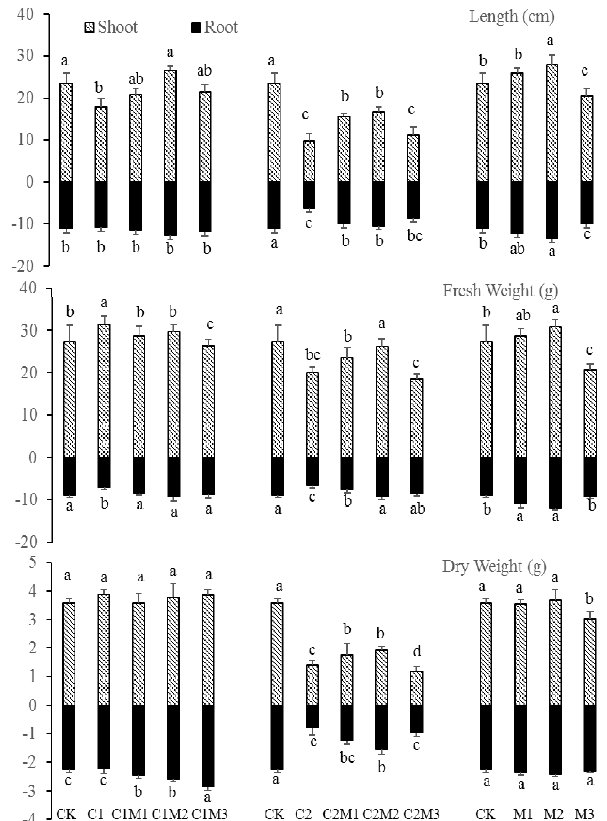
Figure 1. The biomass of rape plants with the co-treatment of Mo and Cd ( n = 4). Note: Data are the mean ± standard deviation. Di ff erent lowercase letters above or below the error bars indicate significant di ff erences ( p < 0.05). CK (control group), C1 (treatment by 0.5 mg / kg Cd), C1M1 (treatment by 0.5 mg / kg Cd and 50 mg / kg Mo), C1M2 (treatment by 0.5 mg / kg Cd and 100 mg / kg Mo), C1M3 (treatment by 0.5 mg / kg Cd and 200 mg / kg Mo), C2 (treatment by 6.0 mg / kg Cd), C2M1 (treatment by 6.0 mg / kg Cd and 50 mg / kg Mo), C2M2 (treatment by 6.0 mg / kg Cd and 100 mg / kg Mo), C2M3 (treatment by 6.0 mg / kg Cd and 200 mg / kg Mo), M1 (treatment by 50 mg / kg Mo), M2 (treatment by 100 mg / kg Mo), M3 (treatment by 200 mg / kg